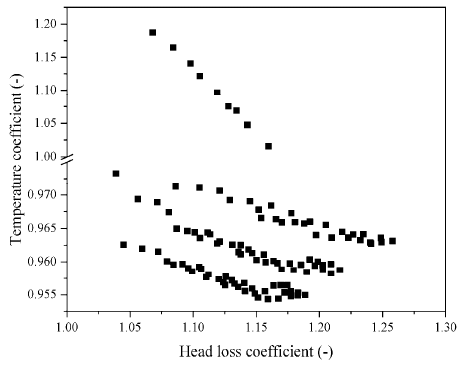
Figure 6. Sensitivity values. Table 4. Statistics of the sensitivity analysis.